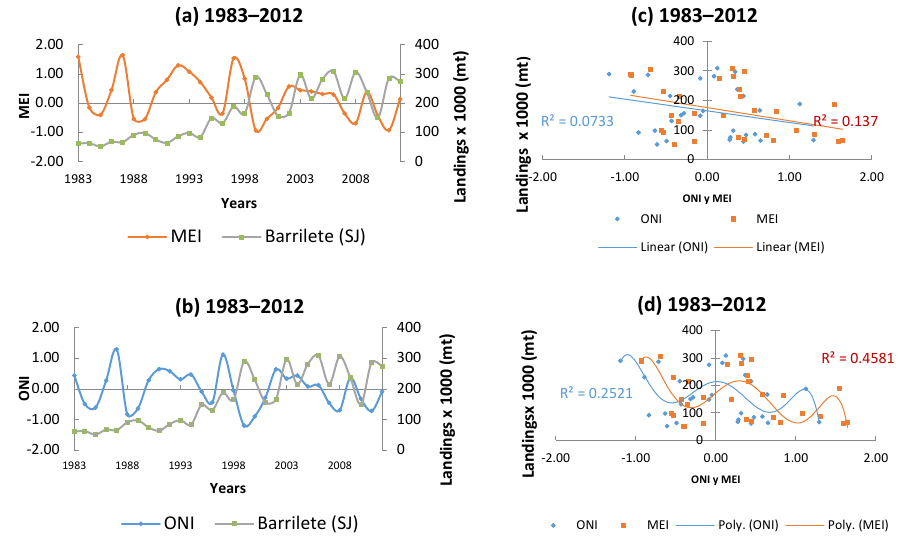
Figure 4. Total Skipjack landings the EPO and MEI (a) and ONI (b) indexes versus time. Linear (c) and non-linear ( n = 6, d ) correlation against MEI/ONI for time series 1983–2012. Data NOAA, CIAT